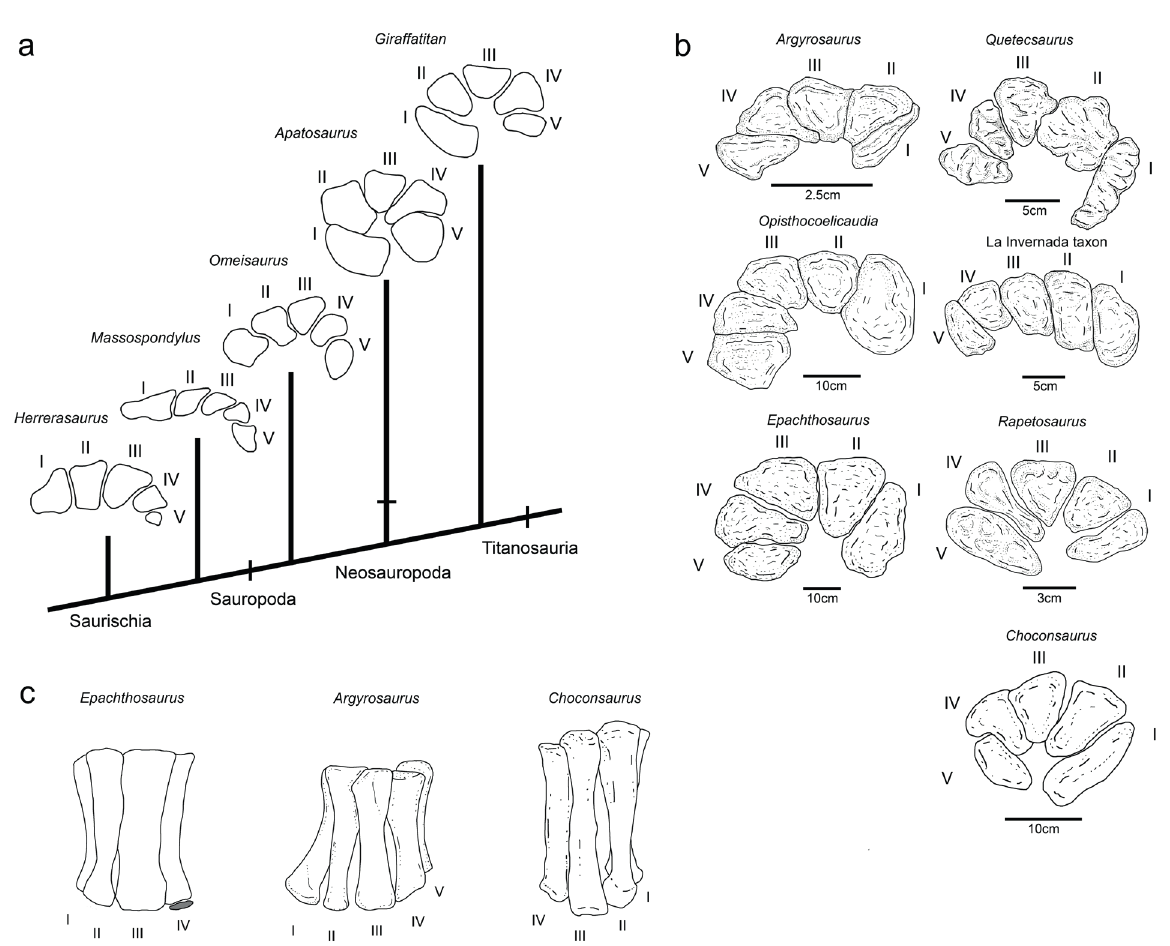
Figure 5 – ( a ) Simplified phylogenetic diagram of right metacarpus shape in proximal view in non-titanosaurian Sauropodomorpha and Herrerasaurus , modified from Bonnan (2003). The name Brachiosaurus has been replaced by Giraffatitan . Not to scale. ( b ) Comparison of left metacarpus of selected titanosaurs in proximal view. Argyrosaurus redrawn from Mannion and Otero (2012), Quetecsaurus redrawn from González riga and Ortiz David (2014), Opisthocoelicaudia redrawn from Borsuk-Bialynicka (1977), La Invernada taxon drawn from personal observation of MUCPv-1533, Epachthosaurus redrawn from Martínez et al. (2004), Rapetosaurus redrawn from Curry rogers (2009), Choconsaurus redrawn from Simón et al. (2018). Not to scale. (c) right metacarpus (anterior view) of Epachthosaurus (with phalanx IV-1 in dark gray) and Argyrosaurus , redrawn and modified from Apesteguía (2005), and left metacarpus (anterior view) of Choconsaurus , redrawn from Simón et al. (2018). roman numerals indicate metacarpal number. Not to